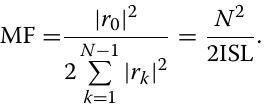
the CAN is the classical algorithm for this design problem, and the other two algorithms are proposed recently. All these algorithms are good at designing aperiodic sequence with low sidelobes and also have high computational effi- ciency. Since the ADMM is inferior to the CAN and Accelerated-MISL algorithms in terms of the aperiodic autocorrelation sidelobes [27], here we do not take the ADMM into account. The stopping criterion is set to be (cid:19) (cid:19)